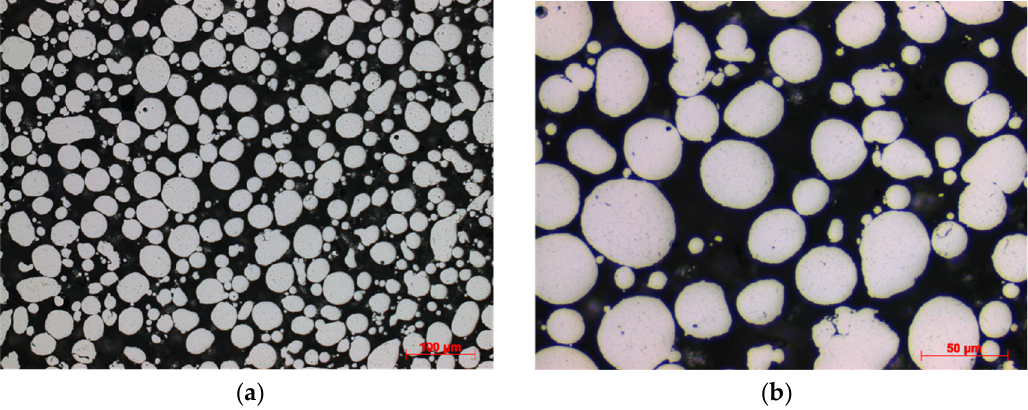
Figure 1. Al 6061 as-received powder at ( a ) low magnification and ( b ) high magnification; particles primarily exhibit a spherical morphology.